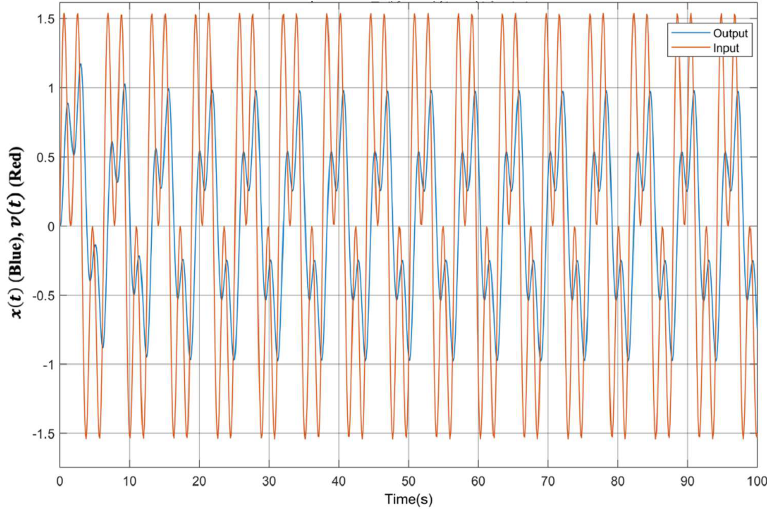
Fractal Fract. 2023 , 7 , 50 Figure 8. Response to the Periodic Input 𝑣(𝑡) = sin𝑡 + sin3𝑡 with Techniques 2 and 3. Figure 8. Response to the Periodic Input v ( t ) = sin t + sin3 t with Techniques 2 and 3.